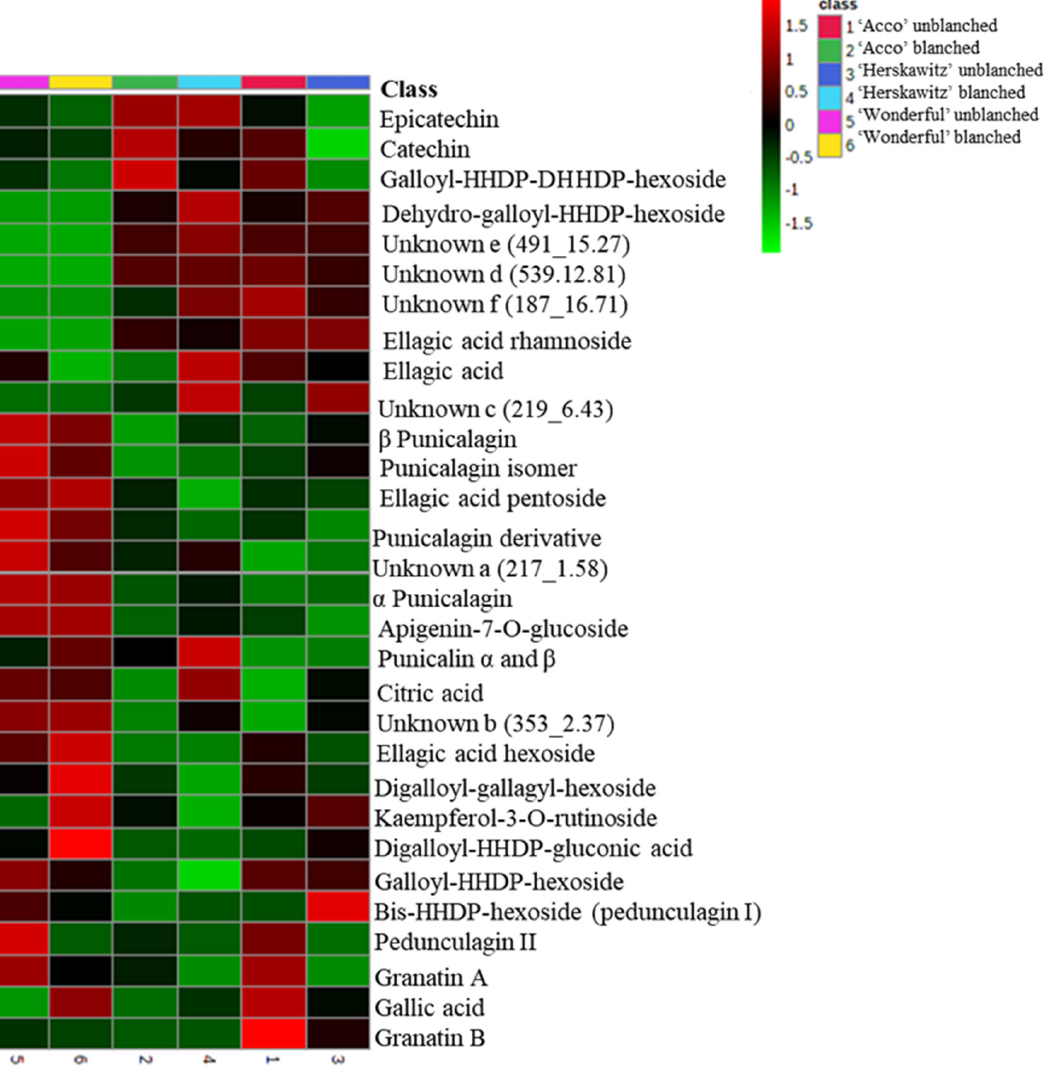
Figure 1. Heat map showing the relative abundance of the identified compounds between ‘Acco’, ‘Herskawitz’, and ‘Wonderful’pomegranate peel extracts. The red boxes show higher mean concentra- tions among different pomegranate fruit samples, while the green boxes show lower concentrations. All cultivars were harvested at the ripe stage (commercial harvest).